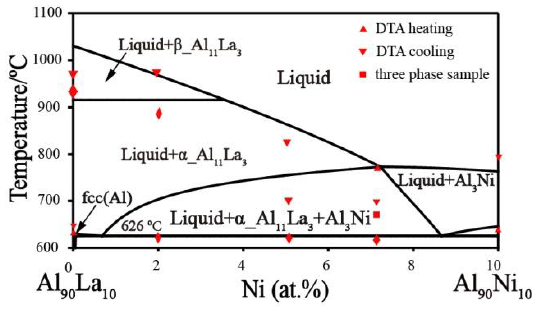
Figure 9. Isothermal section of the Ni – Al – La ternary system at 1000 °C. ( a ) Our calculated isothermal section compared with the experimental results, ( b ) literature data [15].